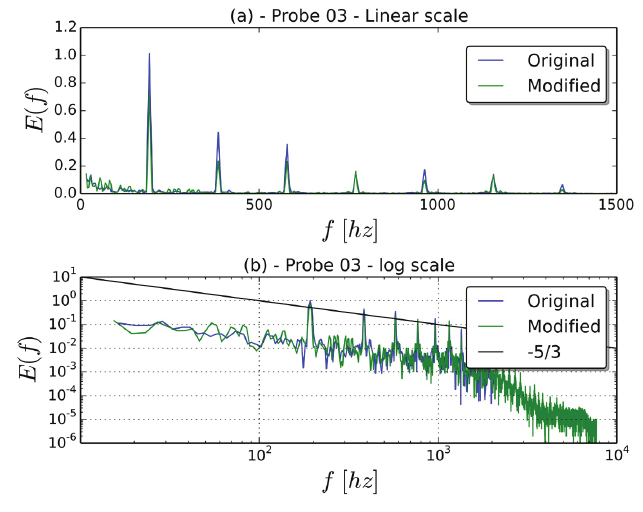
Figure 33 - Energy spectra for probe 3; (a) : in linear scale; (b) : log scale.